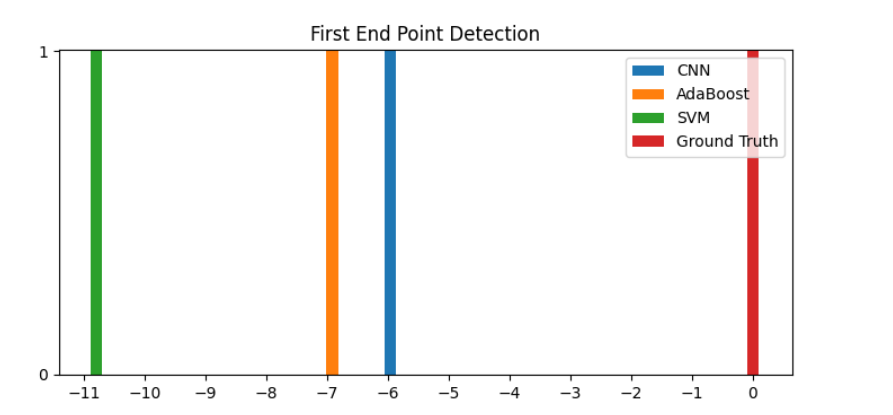
Figure 9. Averages of first end point detection for the three models. The SVM classifier has the mean of 1.079 s ahead of the actual endpoint, the Adaboost does 0.691 s, and the CNN does 0.596 s.